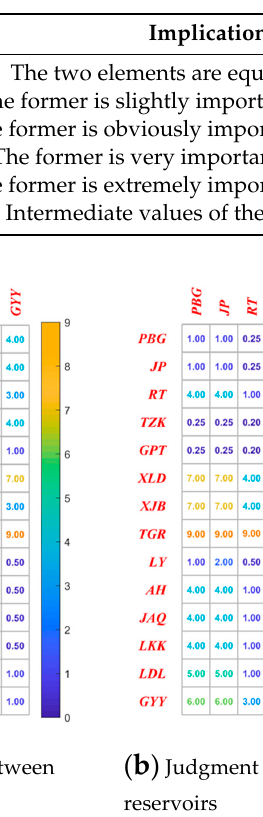
Figure 5. Judgment matrix between reservoirs. Table 6. Implication of importance scale.